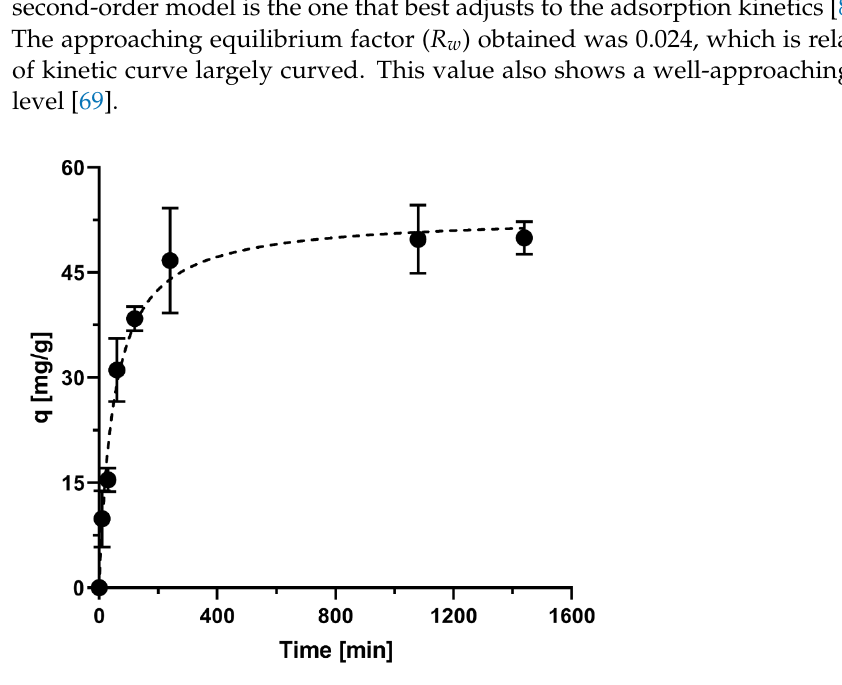
Figure 10. Effect of contact time on removal Cu(II) ions. The kinetic curve for Cu(II) is based on the pseudo-second-order model.